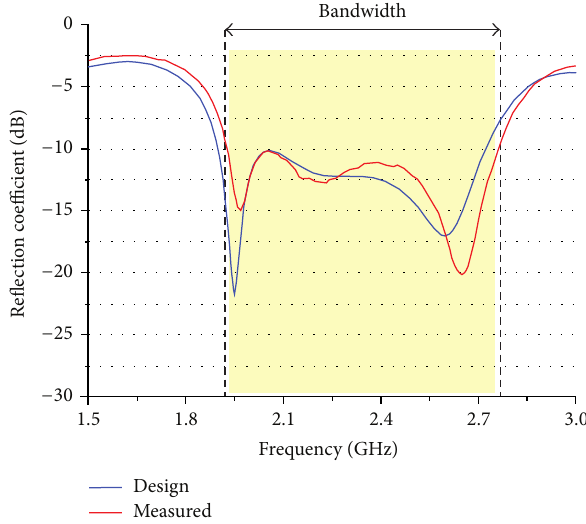
Figure 3: Comparison between simulated and measured results for the reflection coefficient at the antenna input.